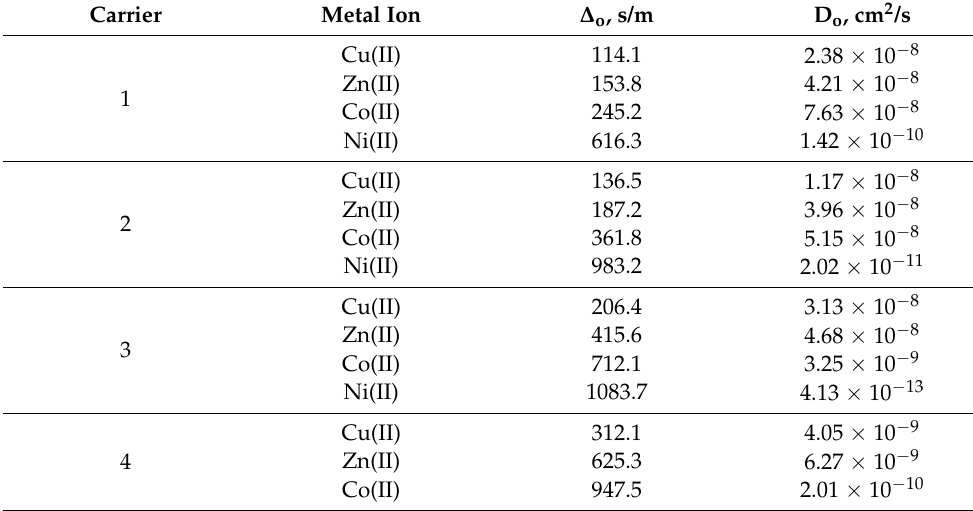
Diffusion coefficients (Do) of Cu(II), Zn(II), Co(II), and Ni(II) complexes with 2- alkylimidazoles and membrane diffusion resistance values ( ∆ o ).